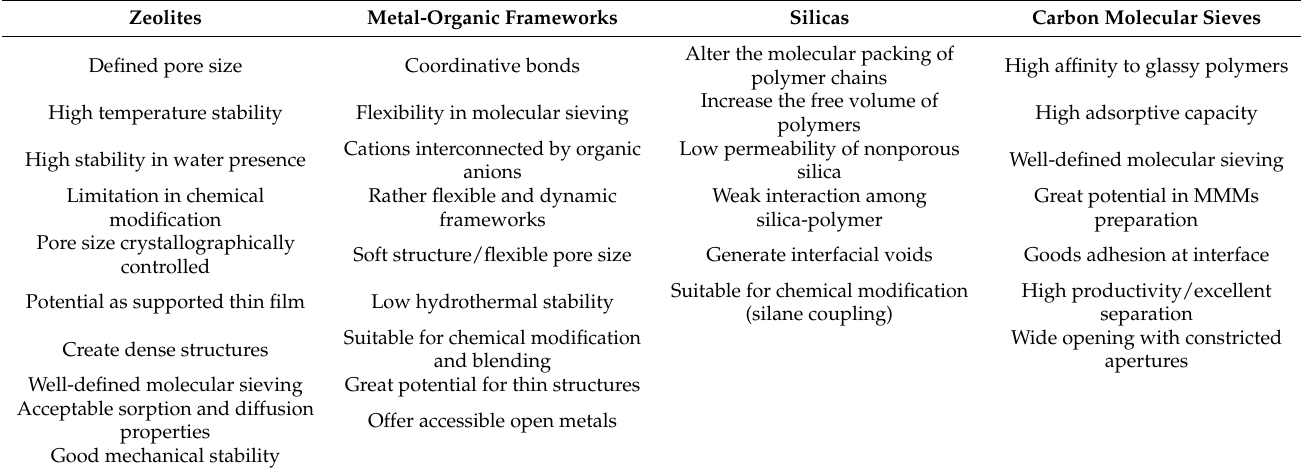
Table 1. Characteristics of materials used in membrane